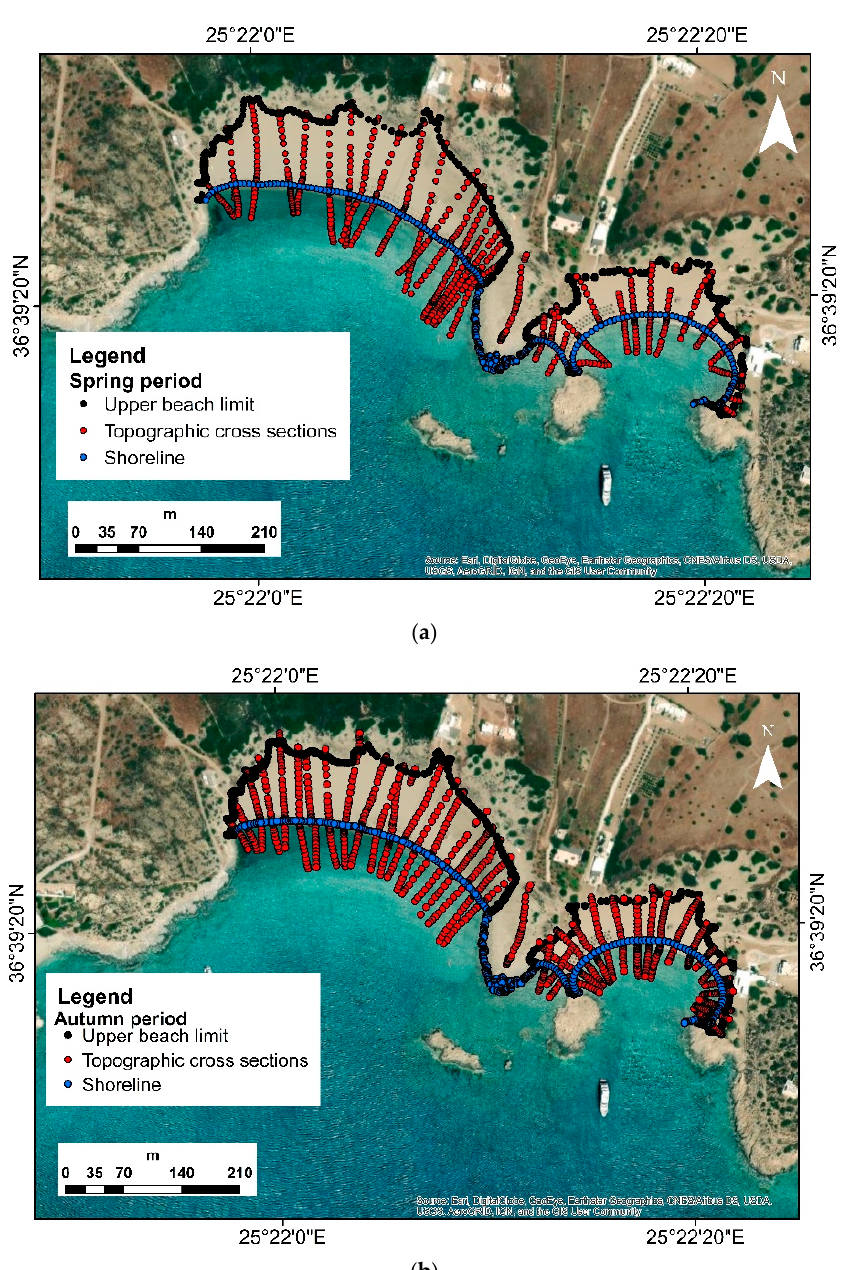
Figure 5. Magganari beach map. All dots are indicating DGPS measurement points: black dots indicate the inland beach limit, red dots indicate vertical cross sections in relation to shoreline, blue dots indicating the coastline during fieldwork period. ( a ) Spring profile fieldwork measurements (36 cross-sections). ( b ) Autumn profile fieldwork measurements (42 cross-sections) profile.